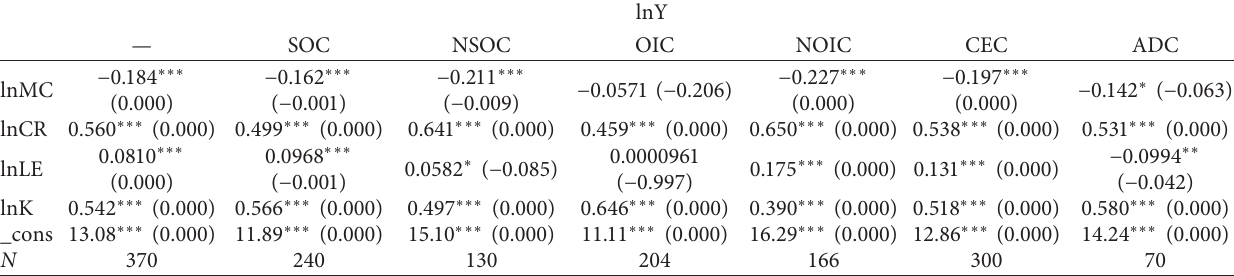
Table 2: Estimation results for turnover equations.